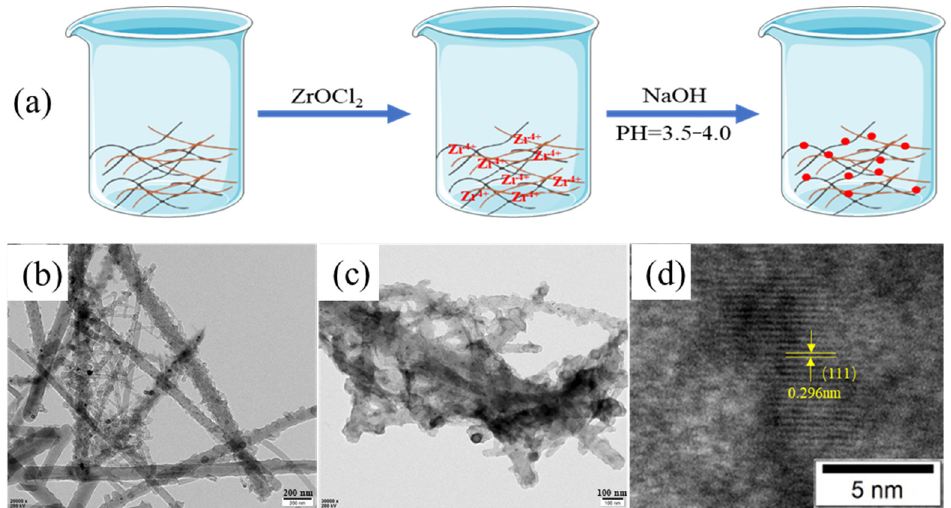
Figure 5. Biomimetic synthesis of ZrO 2 nanoparticles on CaNF/PNF hybrids: ( a ) schematic presentation of the green synthesis process. ( b , c ) Typical TEM images of CaNF/PNF nanohybrids before and after the formation of ZrO 2 . ( d ) HR-TEM image of ZrO 2 NPs on CaNF/PNF-ZrO 2 minerals.